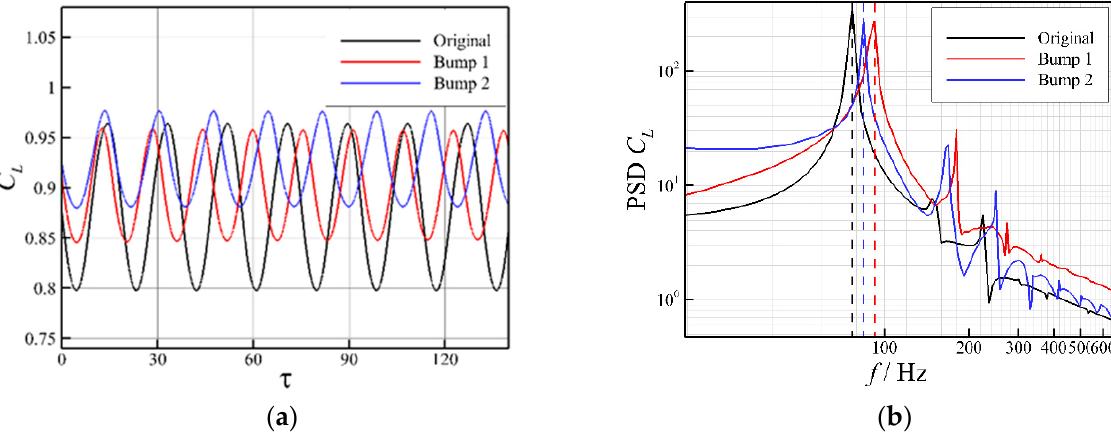
Figure 9. Time-histories of C L and PSD C L for different configurations at the buffet condition. ( a ) Lift coefficient. ( b ) Power spectral density.